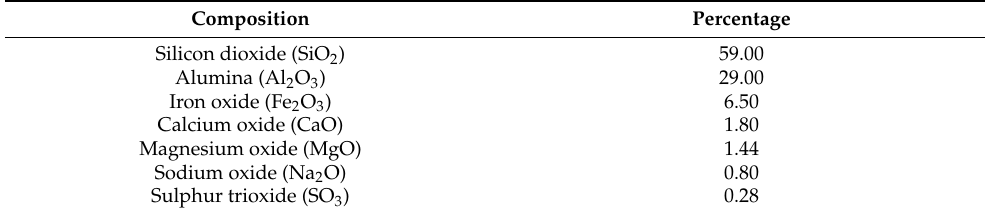
Table 1. Chemical composition of fly ash.